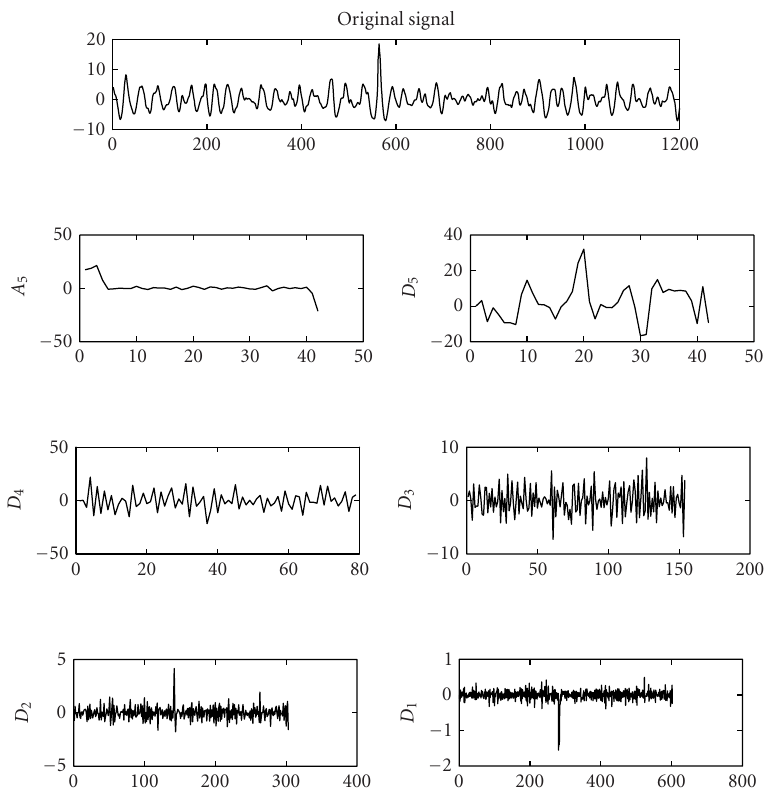
Figure 3.1. Decomposition of time series at level 5 with